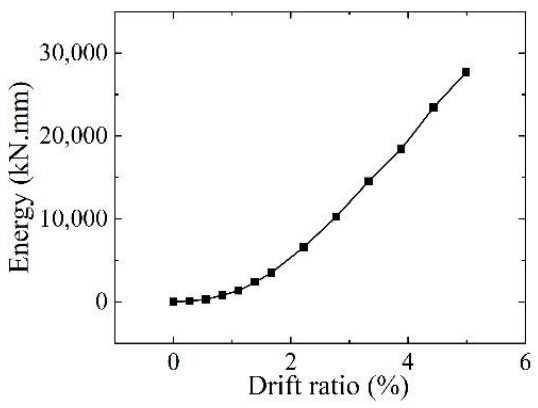
Figure 14. Cumulative energy dissipation.